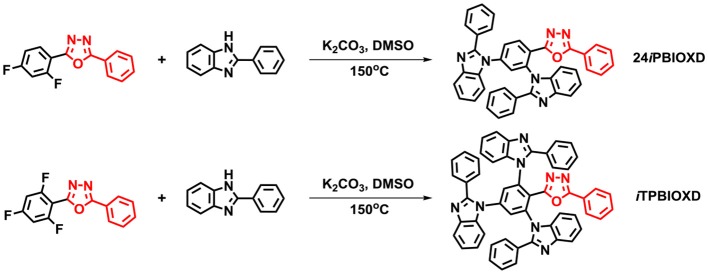
Synthesis of compounds 24iTPBIOXD and iTPBIOXD.